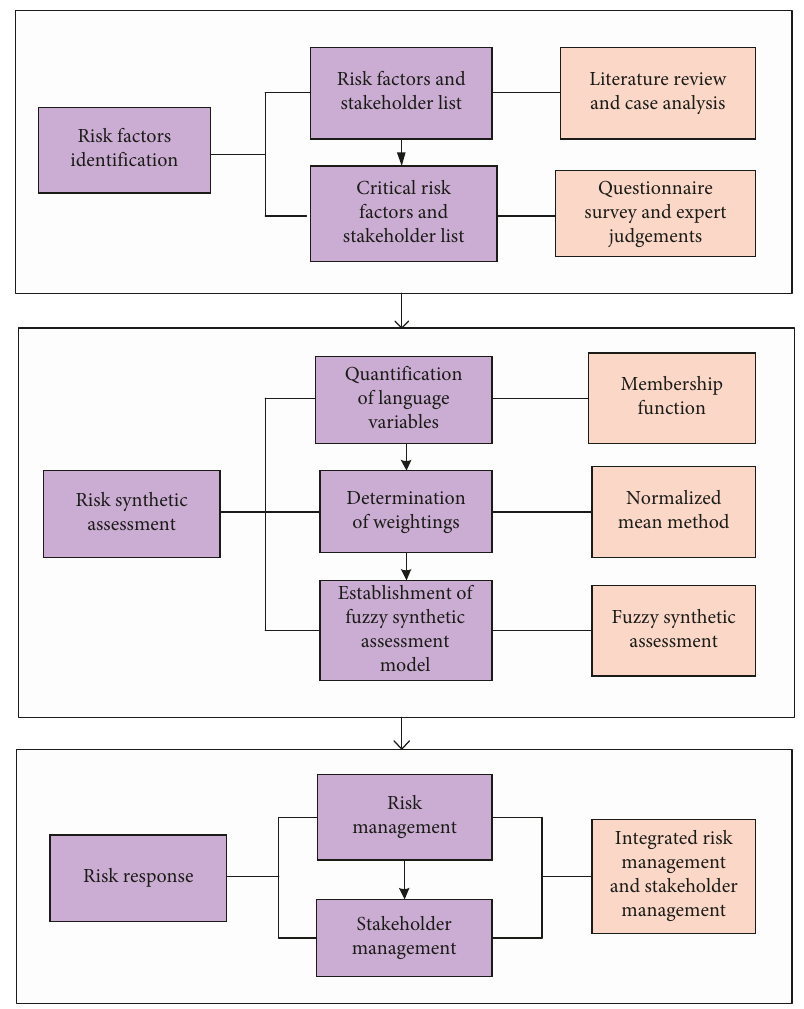
Figure 1: Risk assessment and management